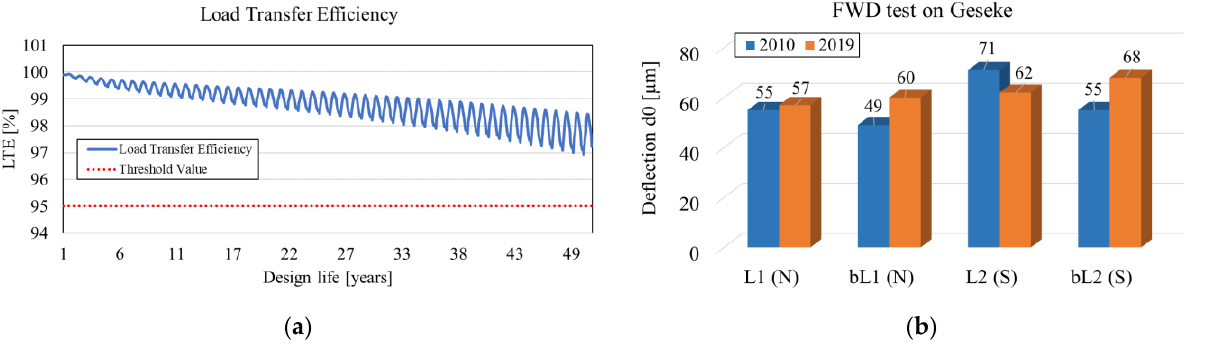
Figure 11. Different findings from design method and on-site measurements for Geseke private road: ( a ) variation of LTE prediction over time from the MEPDG; ( b ) investigation of bearing capacity (FWD) from 2009 to 2019.